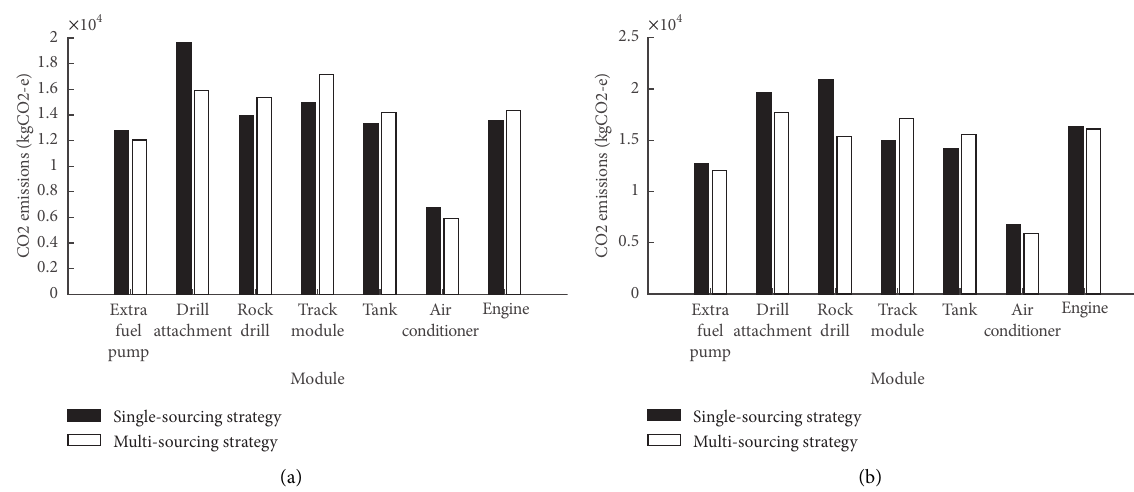
Figure 9: Carbon emissions for single-sourcing and multisourcing strategies under carbon regulations: (a) carbon cap; (b) carbon